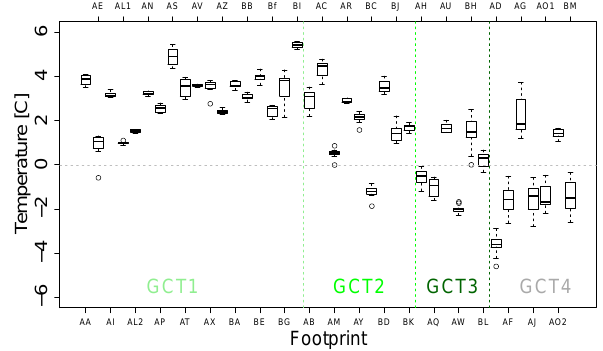
Fig. 4. Boxplots of MAGST of all iButtons at the footprints. The footprints are ordered according to the ground cover types, the vertical dashed lines separate the four GCT groups from each other.